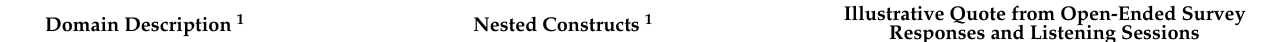
Table 4. CFIR Domains and Nested Constructs Related to TCMLH Program